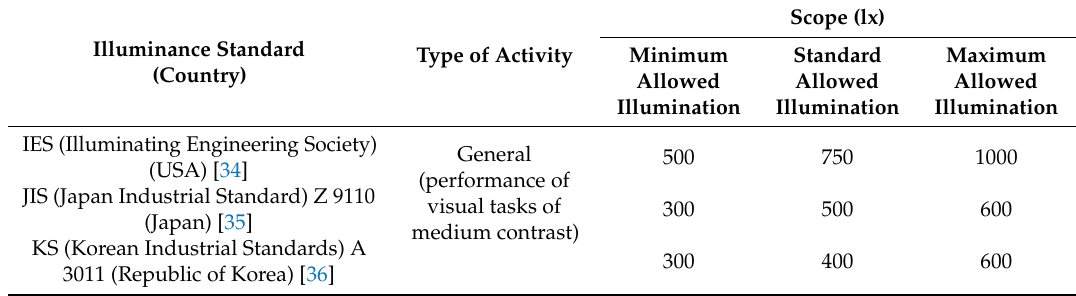
Table 2. Consideration of optimal indoor illuminance standards by